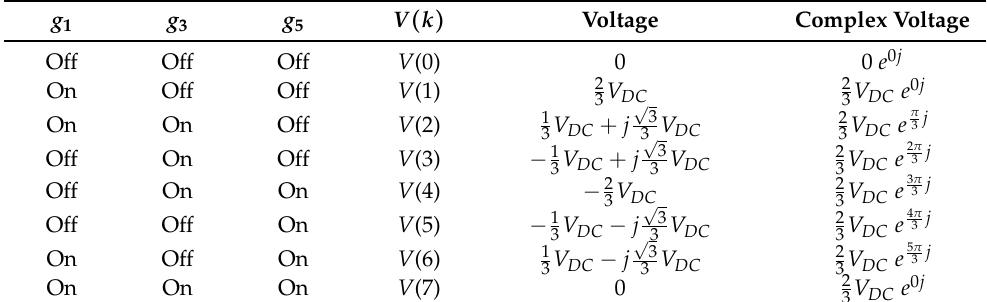
Table 1. VSC-generated